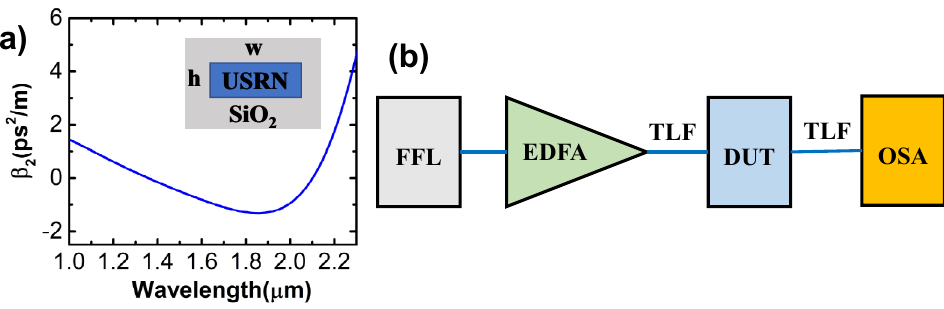
Figure 1. ( a ) Calculated group velocity dispersion (GVD) curve for the fundamental TE mode of a USRN channel waveguide. The insert shows the cross section of the USRN waveguide with a width w = 600 nm and a height h = 400 nm. ( b ) Schematic of the experimental setup for supercontinuum generation in the USRN waveguide, where blue lines denote the polarization maintaining fibers, where FFL: femtosecond fiber laser, EDFA: erbium-doped fiber amplifier, DUT: device under test, TLF: tapered lensed fiber, OSA: optical spectrum